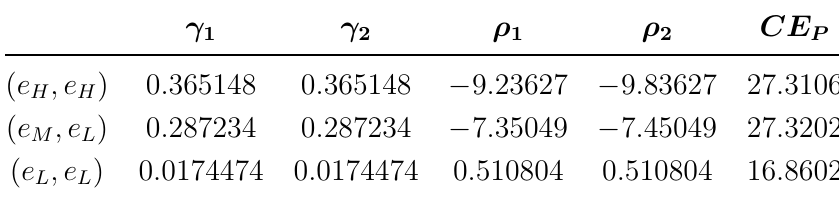
Table A2. Optimal team contracts of Example